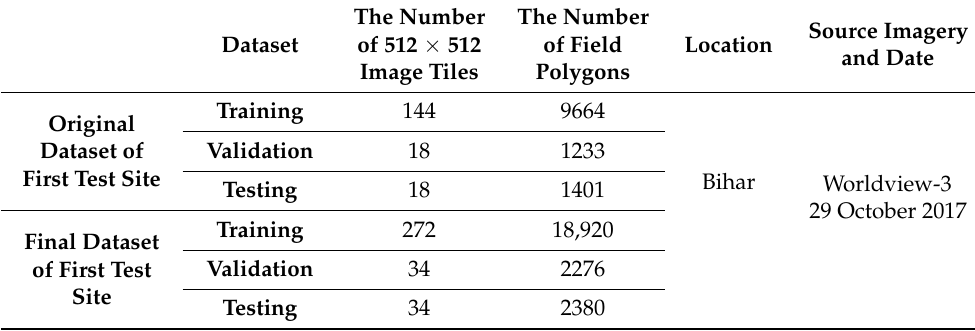
Table 1. Description of training/validation/testing datasets that were used for building and evaluat- ing the models in